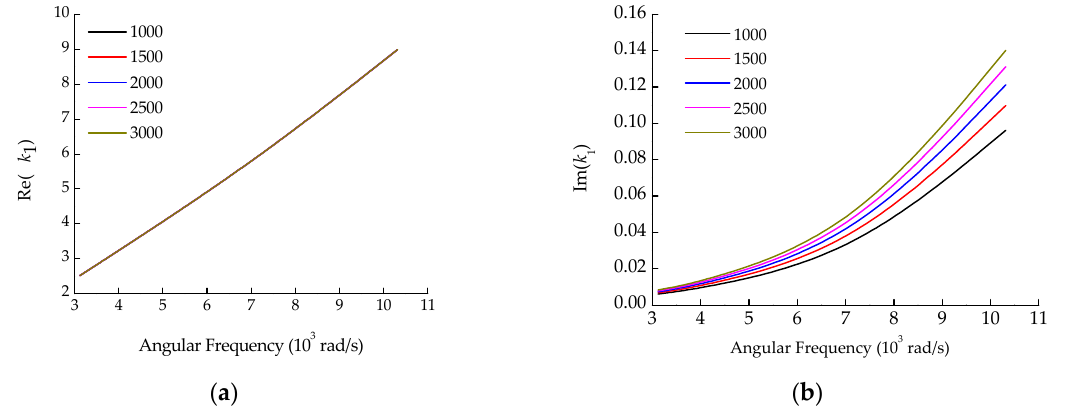
Figure 1. The influence of soil density on wavenumber. ( a ) Real part; ( b ) Imaginary part.